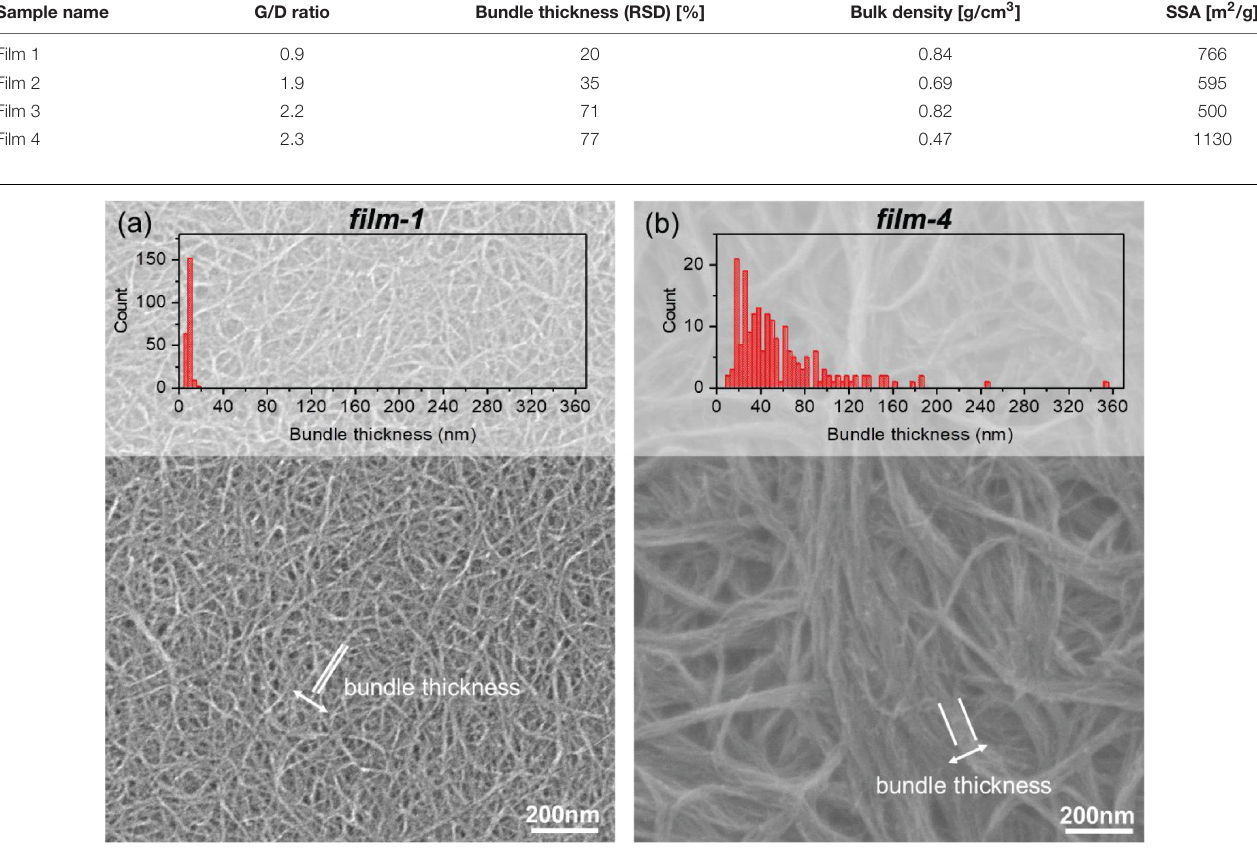
FIGURE 3 | SEM image and CNT bundle thickness distribution of (a) film 1, (b) film